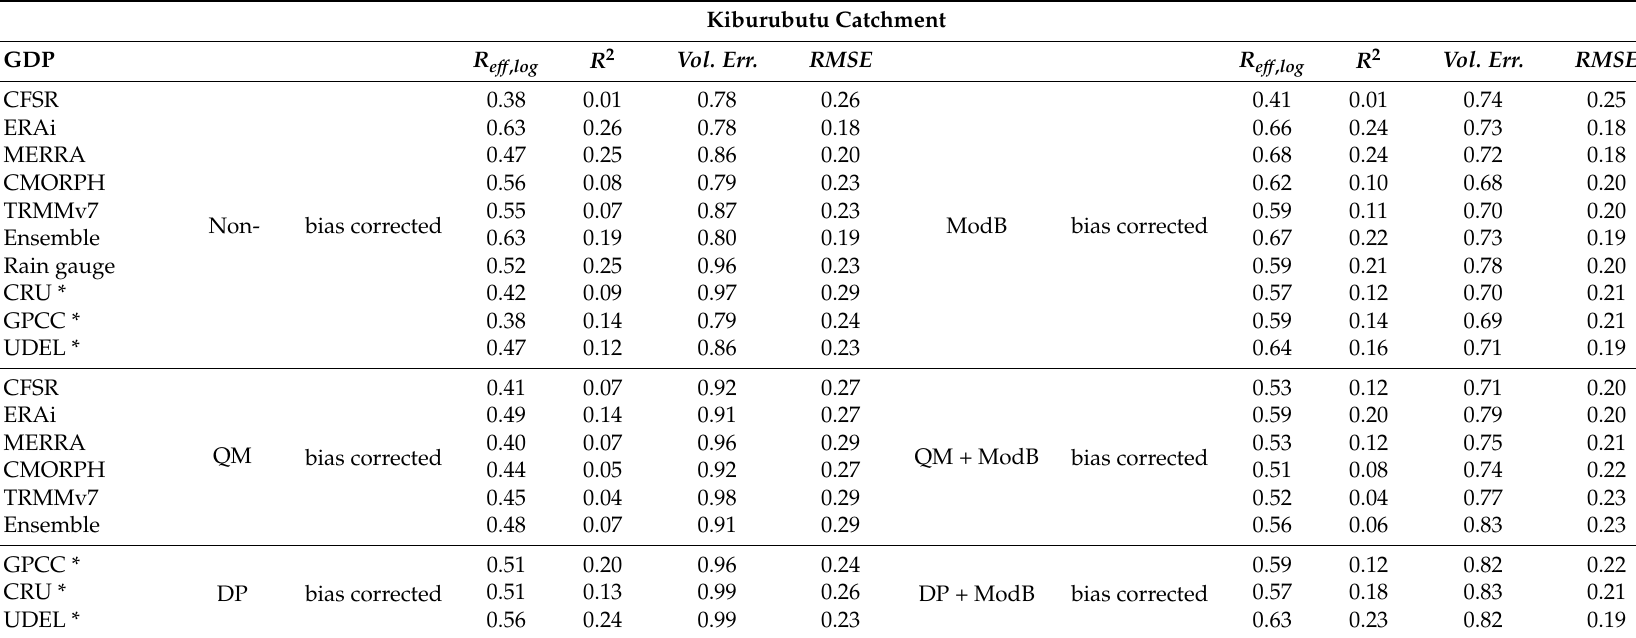
Table 5. Performance scores for KC discharge simulations. Performance is shown as R eff , log , R 2 , Volume Error ( Vol. Err. ), and RMSE values for each bias correction technique